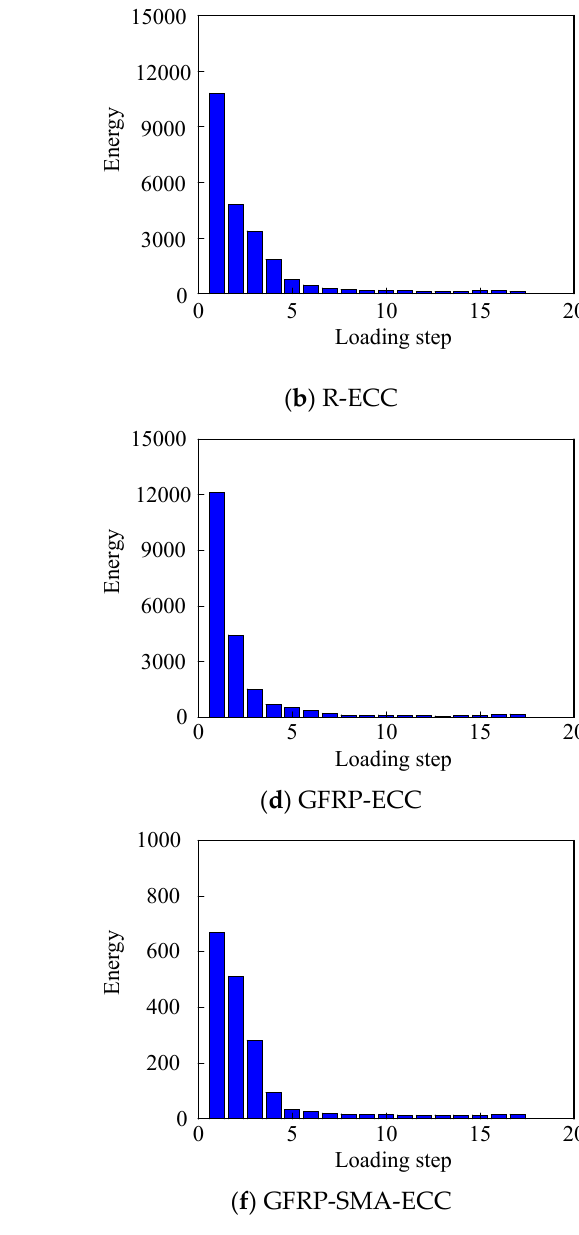
Figure 13. Energy indices for the six beams.